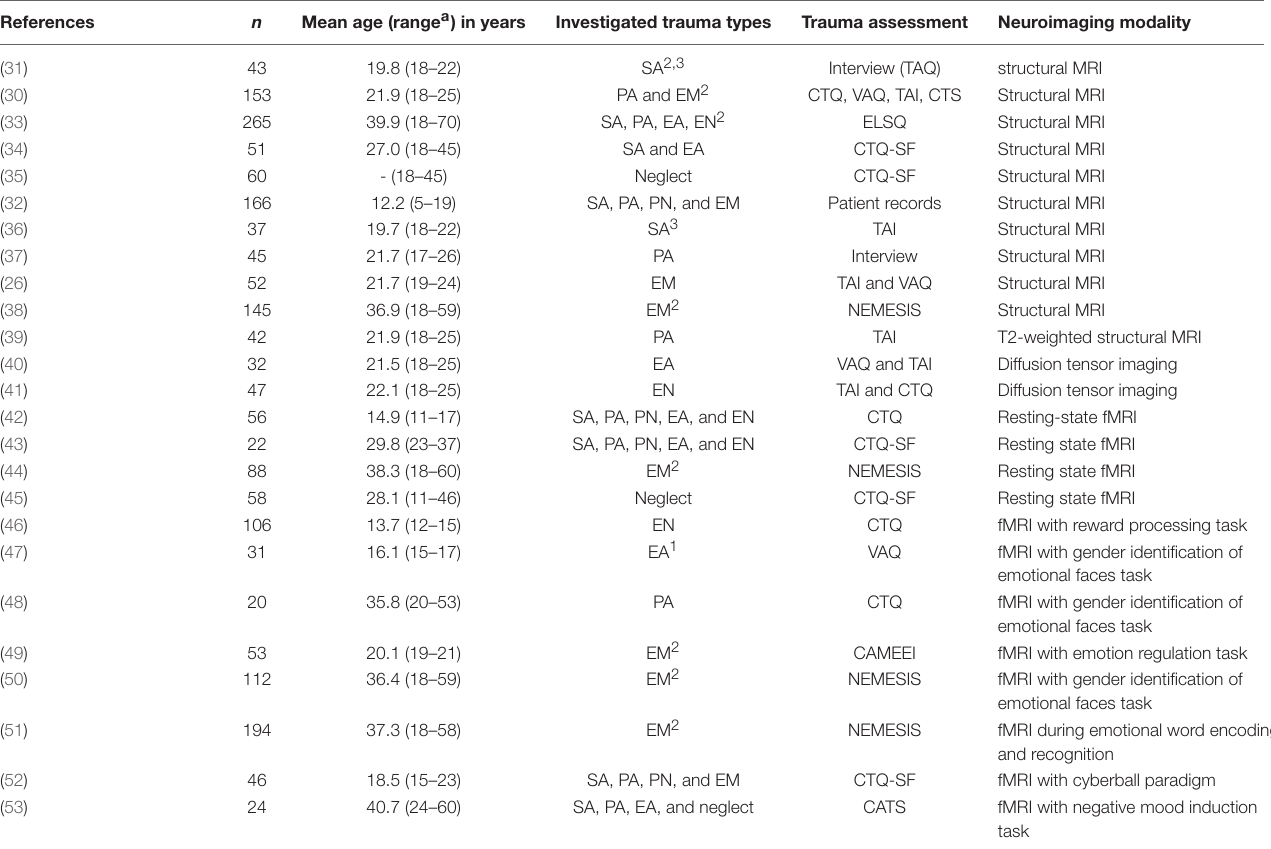
TABLE 2 | Overview of included